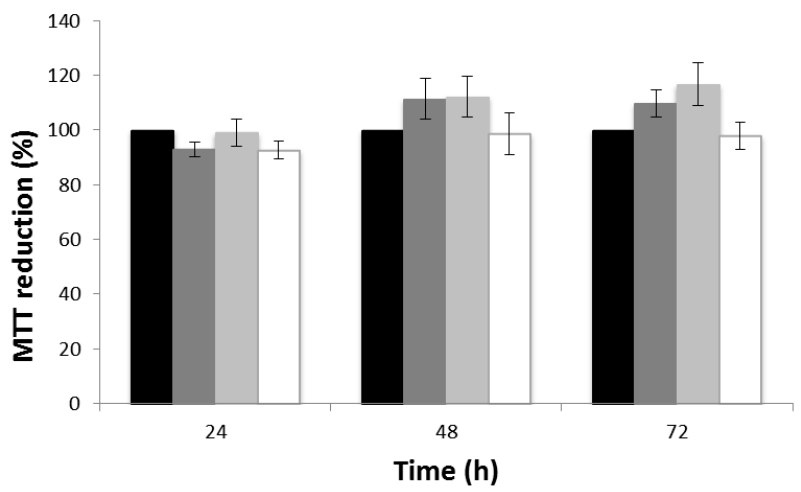
Figure 8. Effect of LC on HaCaT cell viability determined by 3 ‐ (4,5 ‐ dimethyl ‐ 2 ‐ thiazolyl) ‐ 2,5 ‐ diphenyl ‐ 2H ‐ tetrazolium bromide (MTT) assay. Cells were cultured in normal growth medium and then subjected to treatment with LC (black: Control; dark grey: 0.3 µ M; grey: 3 µ M; white: 30 µ M) for 24, 48, and 72 h. Cell viability was evaluated by measuring the A 570nm . Results are expressed as the percentage (means ± SD from at least three experiments) compared to the control.